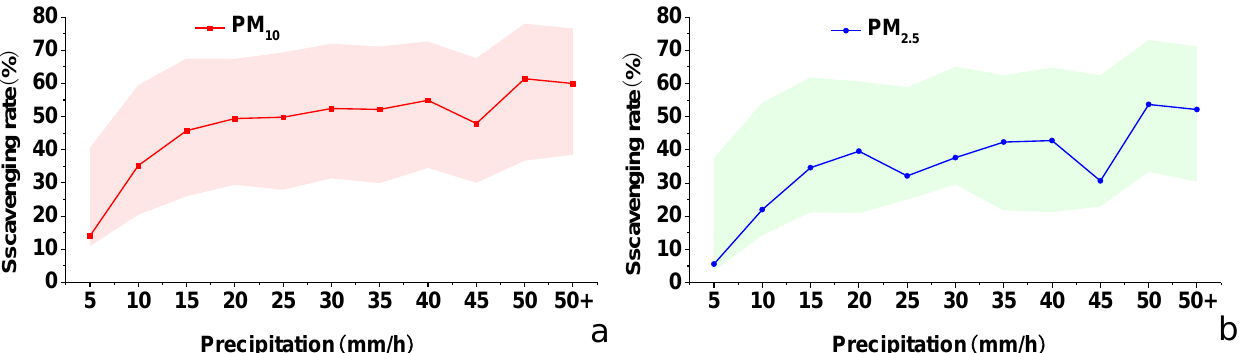
Figure 4. Relationship between precipitation and scavenging rate ( SR ) about the particle mass concentrations (( a ), PM 10 ; ( b ), PM 2.5 ). (The solid line is the arithmetic mean of the SR , and the shaded area is the 25% and 75% percentile values of all the individual cases).